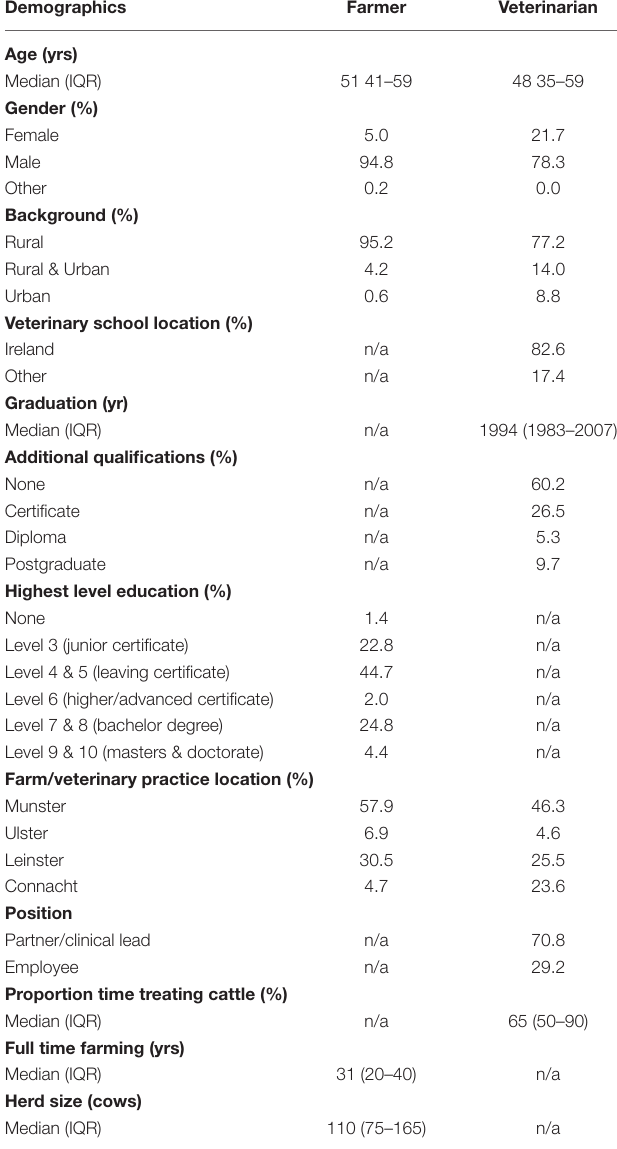
TABLE 1 | Demographics of farmers ( n = 1,002) and veterinarians ( n = 116) that completed a survey on attitudes to pain and analgesic use in pasture-based dairy